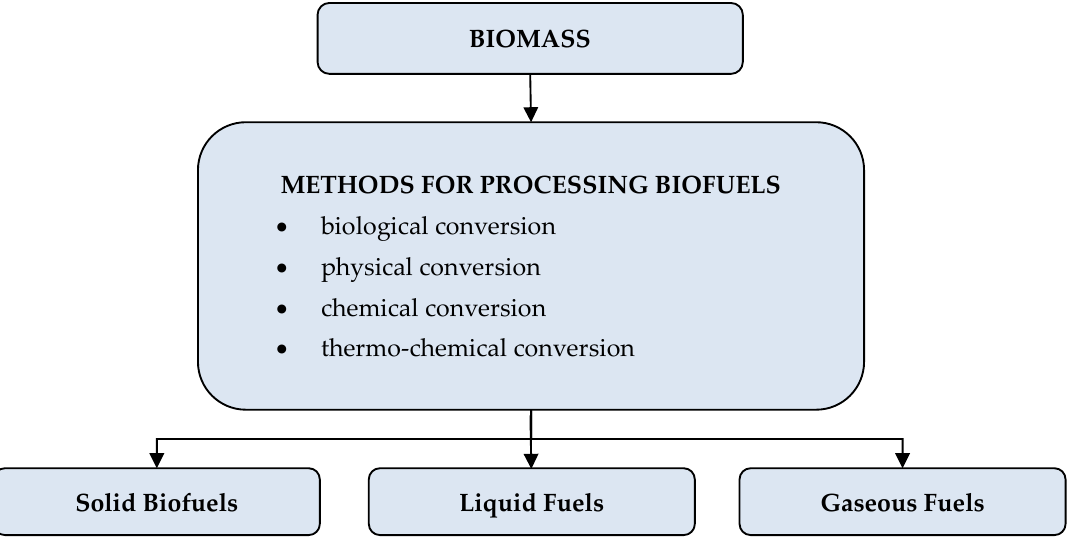
Figure 1. Classification of biofuels.